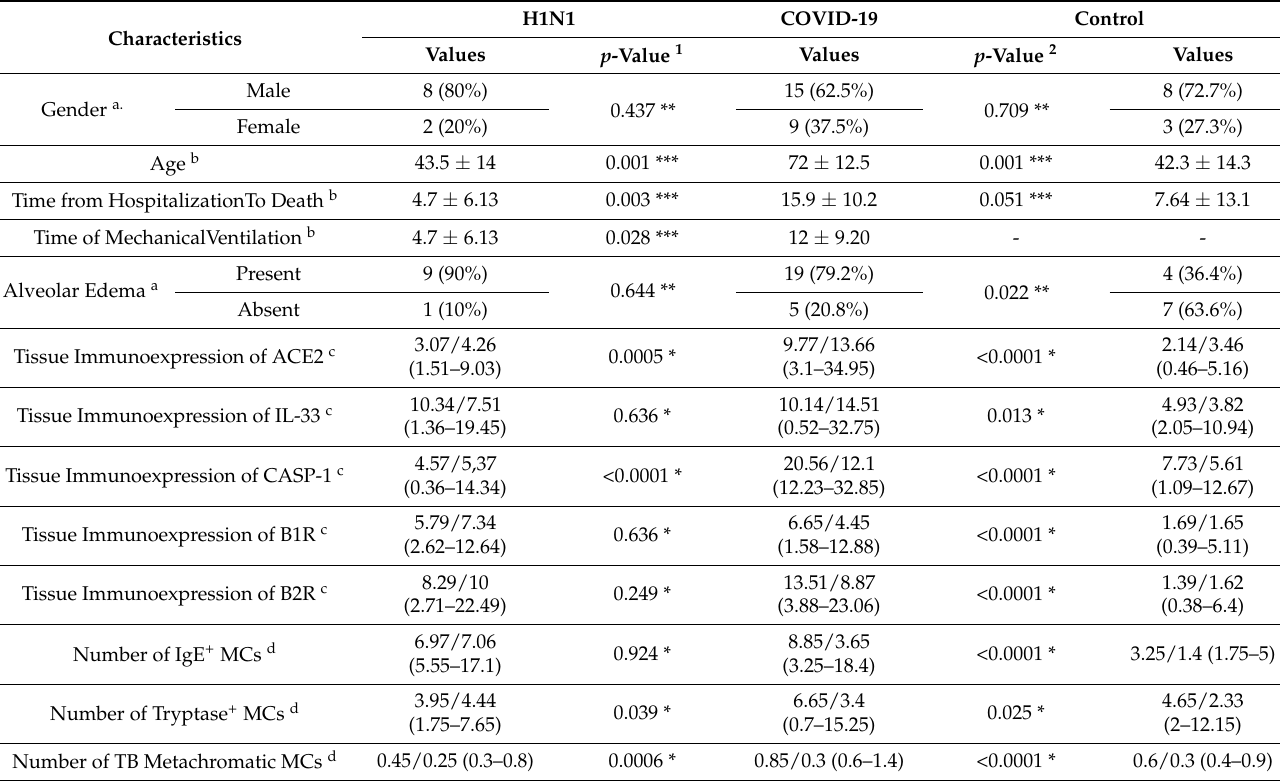
Table 1. Comparison between COVID-19, H1N1 and CONTROL groups according to demographic, clinical, histopathological and immunohistochemical